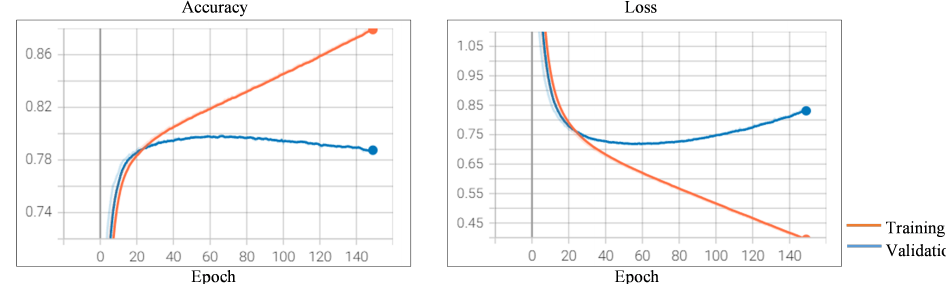
Figure 7. Performance of the improved transformers-base model. This model uses an SGD optimizer and a learning rate of 1 × 10 − 4 over 150 epochs. The other hyperparameters are set the same as the model built in the preliminary experiments.